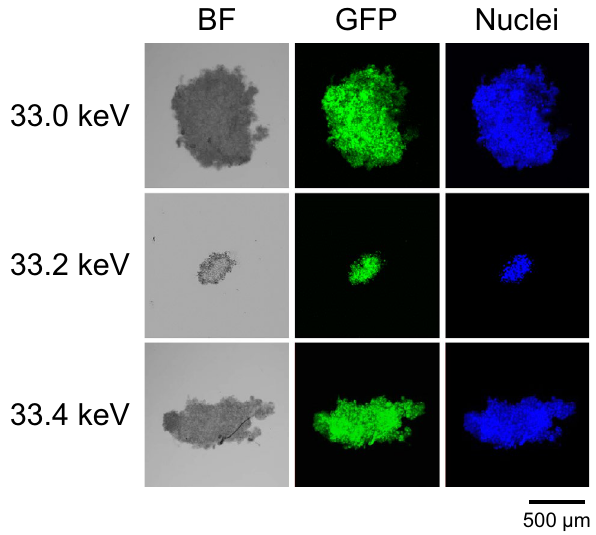
Figure 4. Energy dependence of tumor spheroid destruction. Tumor spheroids incubated with IPO were irradiated with three different monochromatic X-rays (33.0, 33.2 or 33.4 keV) for 30 min. GFP and nuclear staining were used to follow the destruction.